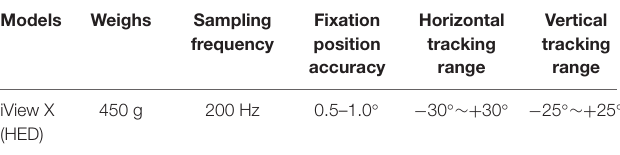
TABLE 2 | Eye tracker parameter. Models Weighs Sampling